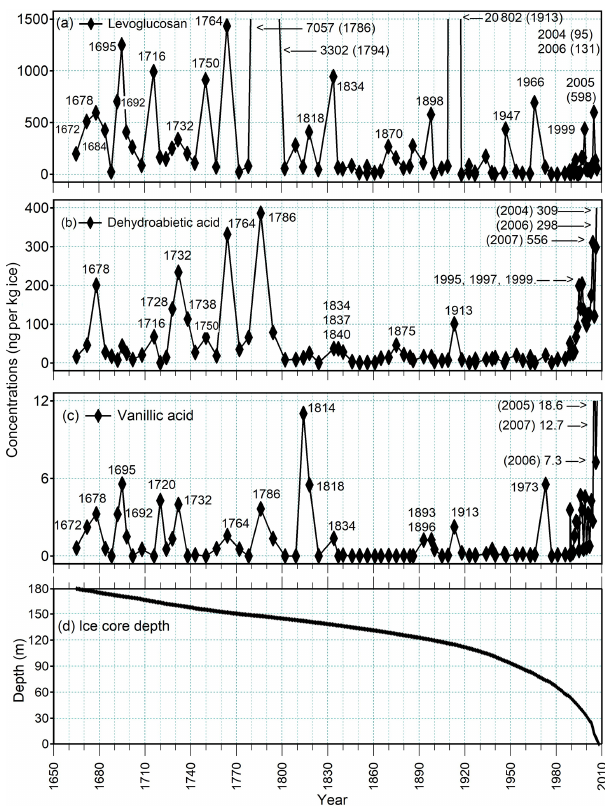
Figure 3. Concentration changes of (a) levoglucosan and (b) dehy- droabietic and (c) vanillic acids in the ice core, and (d) depth of the ice core collected from Aurora Peak in Alaska for